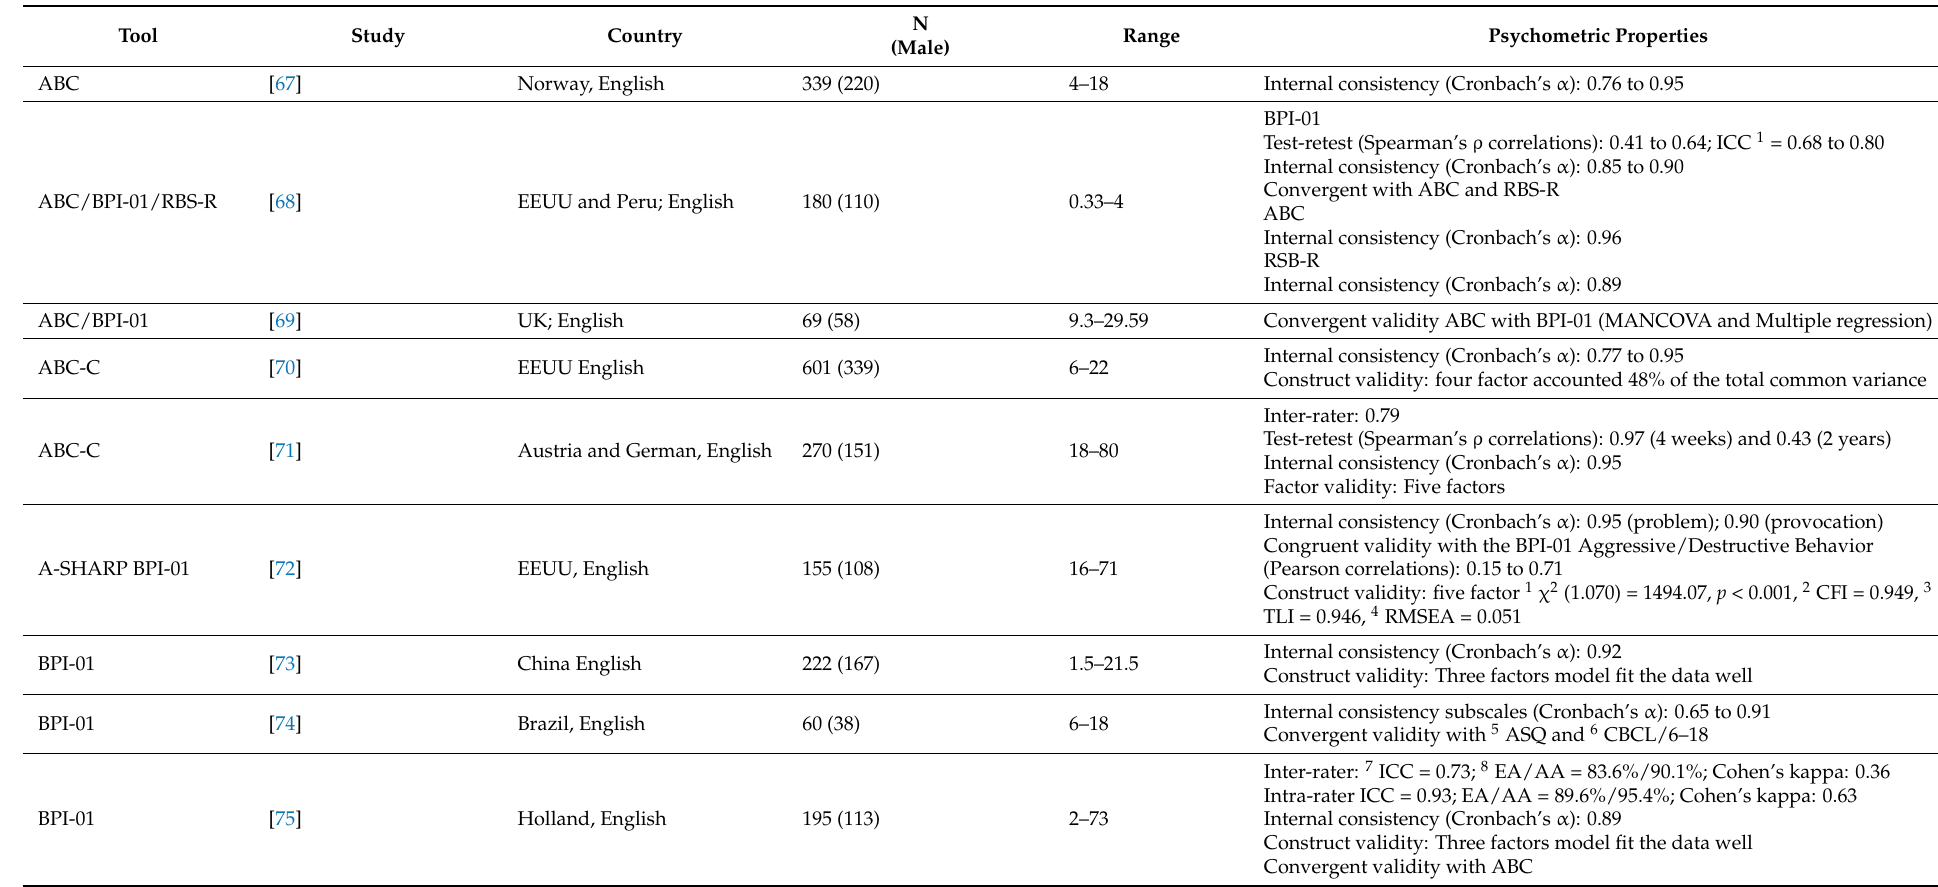
Table 2. Measurement studies of challenging behavior